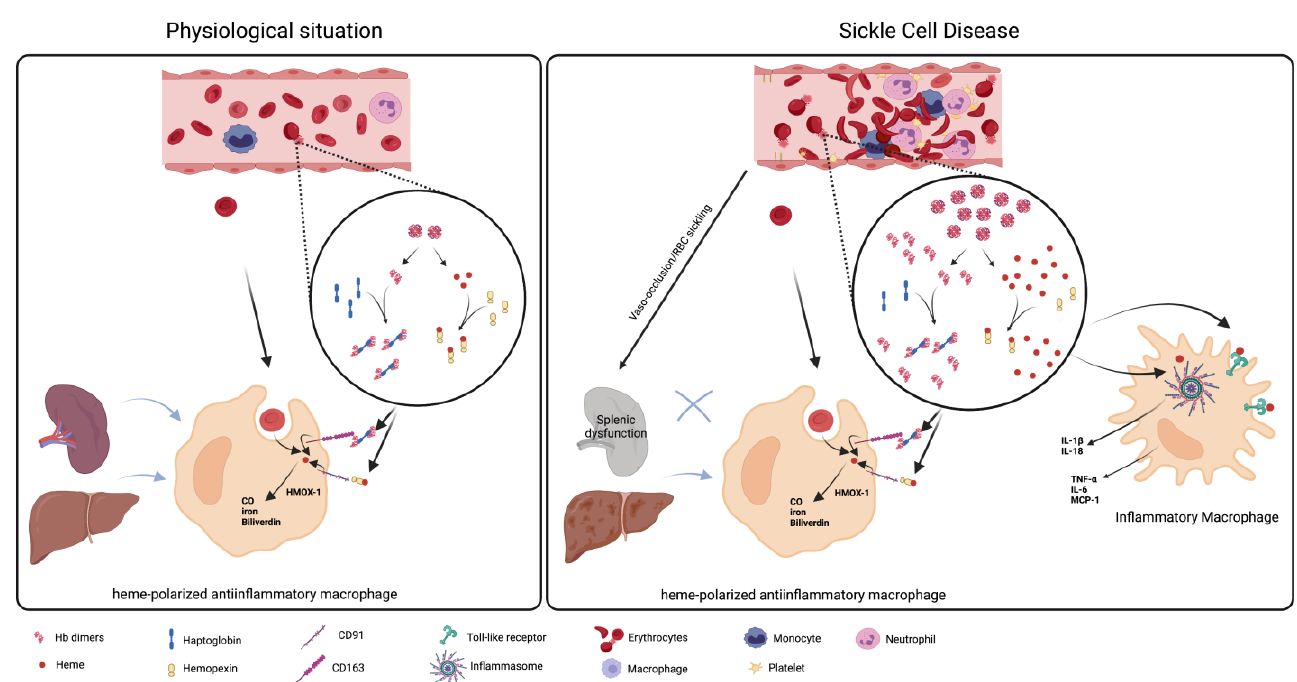
Figure 1. Macrophage clearance of red blood cells and hemoglobin products in sickle cell disease. Under normal physiological conditions, damaged or senescent erythrocytes are erythrophagocytosed extravascularly, primarily in the spleen. The elevation of intracellular heme during erythrophagocytosis transforms the cells into erythrophagocytes that process hemoglobin and recycle iron, preventing the damaging effects of these molecules. Scavenger proteins, such as haptoglobin and hemopexin, which bind cell-free hemoglobin and heme molecules, respectively, counter physiological levels of red blood cell (RBC) lysis in the vasculature and their release of cell-free RBC products. Haptoglobin–hemoglobin and hemopexin–heme complexes bind to the CD163 and CD91 receptors, respectively, on macrophages, particularly in the liver, where these molecules are broken down by heme oxygenase-1 (HMOX-1) into iron, carbon monoxide (CO), and biliverdin. These heme-polarized macrophages have an anti-inflammatory phenotype that differs from those of classic M1/M2-polarized macrophages. In sickle cell disease, vaso-occlusive processes and congestion of the spleen causes splenic dysfunction, reducing the erythrophagocytosis of senescent RBCs. In association with the skewing of hemolysis to occur intravascularly, hemoglobin polymerization and RBC sickling significantly augment RBC damage and the lysis of these cells in the circulation. Considerable elevations in cell-free hemoglobin and heme saturate hemoglobin clearance proteins, leading to the binding of heme to pattern recognition receptors, such as Toll-like receptors, on macrophage membranes and the entry of unbound heme into these cells. Innate immune pathways, including inflammasome formation, are triggered and macrophages take on an inflammatory phenotype, resulting in inflammatory molecule production and pyroptosis. Created with Biorender.